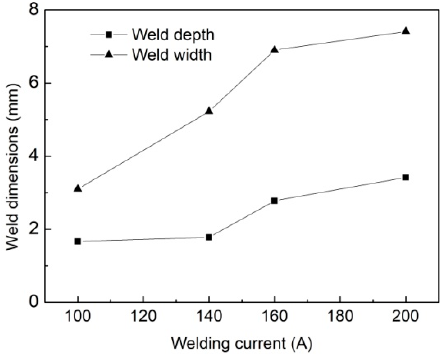
Figure 5. Hybrid weld dimensions for different welding currents.